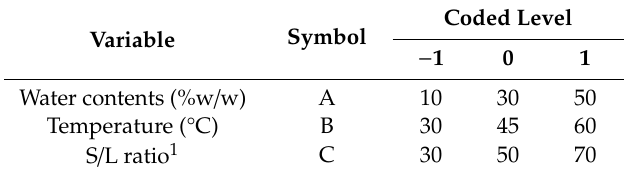
Table 6. Investigated variables and their levels in a three-level Box–Behnken (BBD)